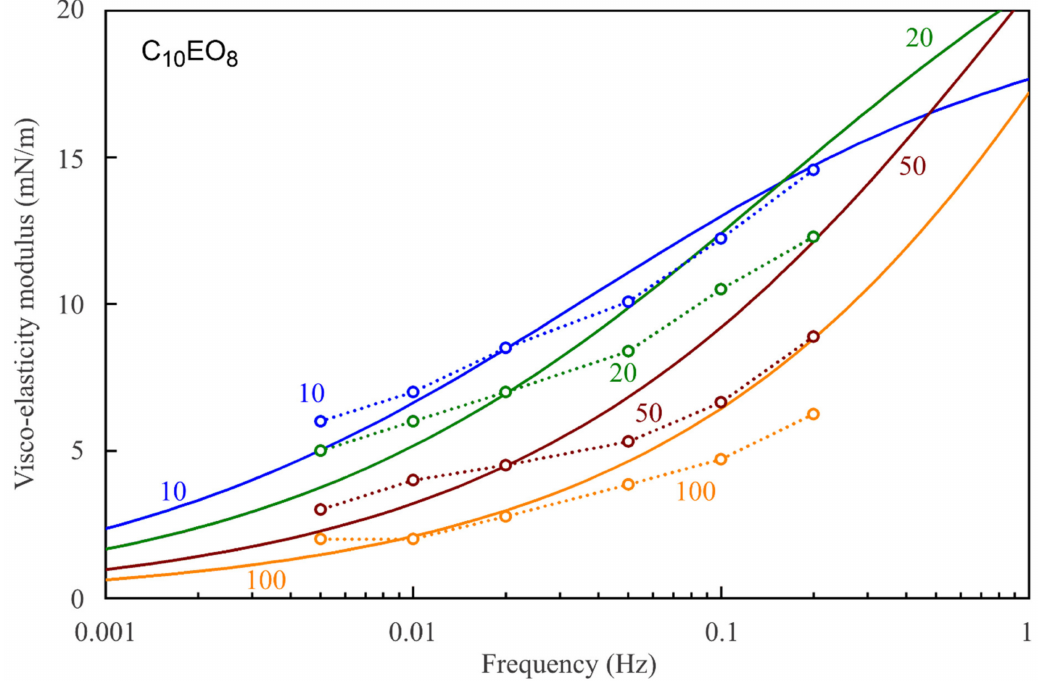
Figure 8. Experimental visco-elasticity modulus vs. frequency for C 10 EO 8 solutions of different concentrations (10, 20, 50, and 100 µ mol/L, as indicated by numbers) and the respective theoretical curves calculated with the LvT equation, Equation (8), with E 0 (c) and ω D (c) calculated by using the reorientation model, Equations (1)–(6), with the parameter values presented in Table 1. Dotted lines are guides for the